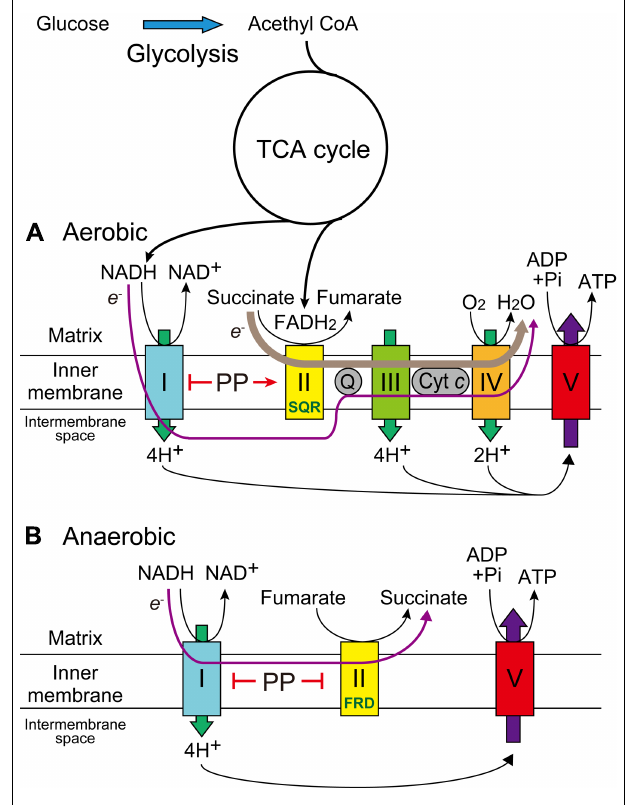
FIGURE 1 | Effects of PP on the mitochondrial electron-transport chain under aerobic or anaerobic conditions. (A) In mammals under normal aerobic conditions, PP inhibits complex I but activates complex II SQR activity, thereby maintaining cellular respiration and ATP production. (B) In parasites or mammals under anaerobic conditions, the NADH-fumarate reductase system maintains ATP production with no need of oxygen by only using proton gradients via complex I. PP inhibits both complex I and complex II FRD activity, thereby showing potent inhibition of ATP